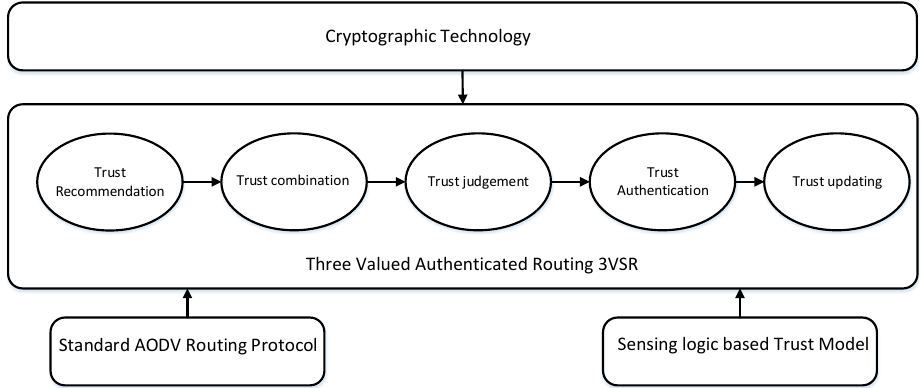
Figure 3. Frame work for the proposed scheme, the standard AODV is applied at second stage with enabling sensing logic-based trust model, while cryptographic technology is considered to take effect before this